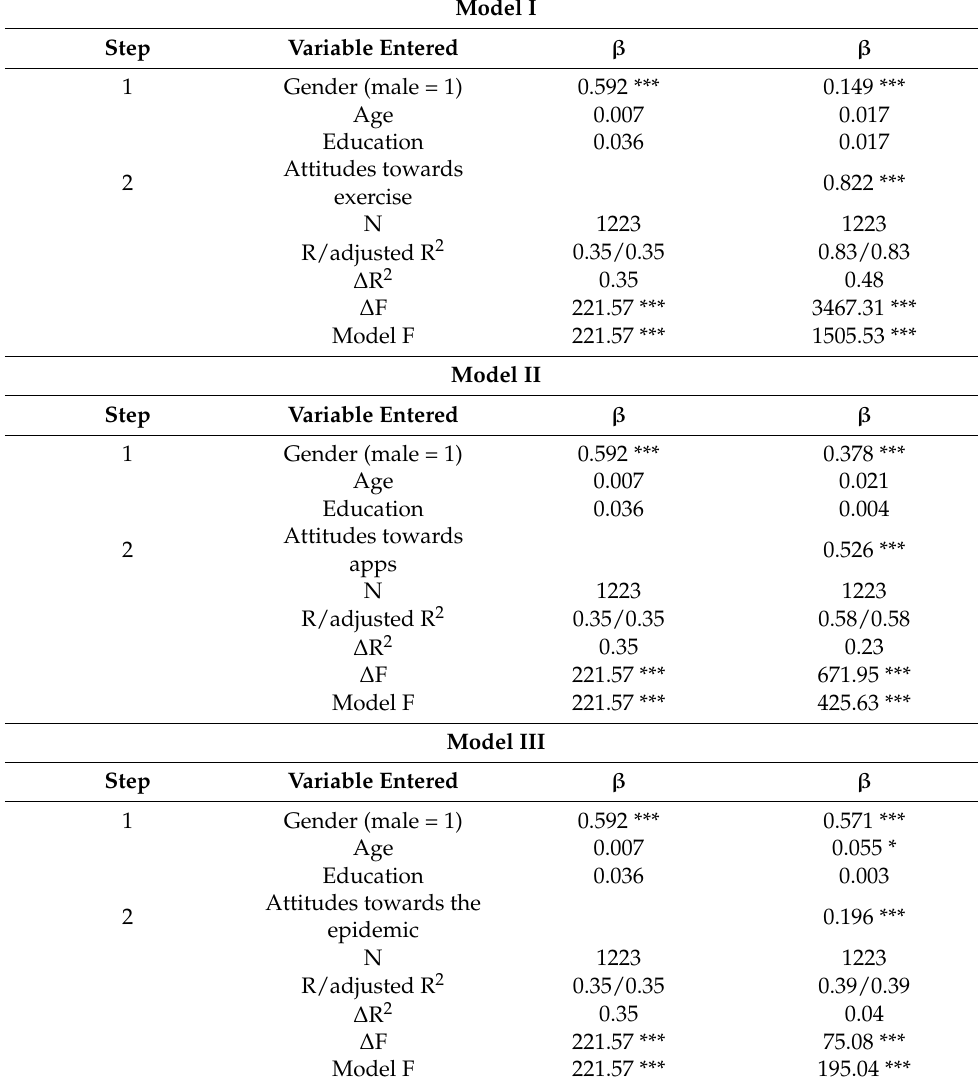
Table 3. Multiple linear regression of intention to use exercise behaviours (or PA) to resist COVID-19. Model